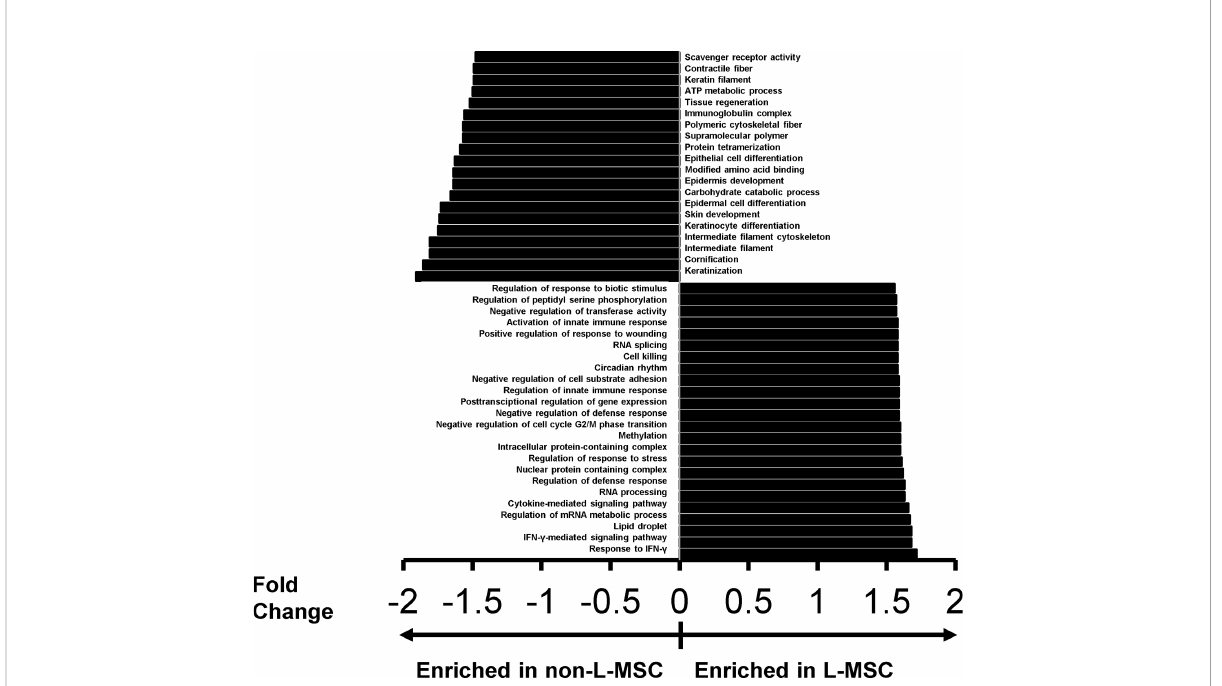
FIGURE 2 The top protein sets that are differentially expressed (P<0.01) in L-MSC versus non-L-MSC secretome. The secretome data was subjected to protein ontology analysis to investigate the correlations between the intergroup differences and the functional changes observed on the immunomodulatory roles of MSCs from different tissue sources. Protein sets are that are enriched in the secretome of non-L-MSC are demonstrated at the top, and those enriched in the secretome of L-MSC are demonstrated at the